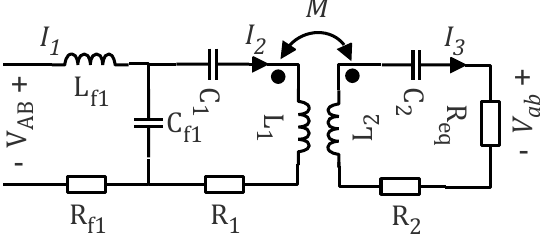
Figure 4. Equivalent diagram of proposed system.